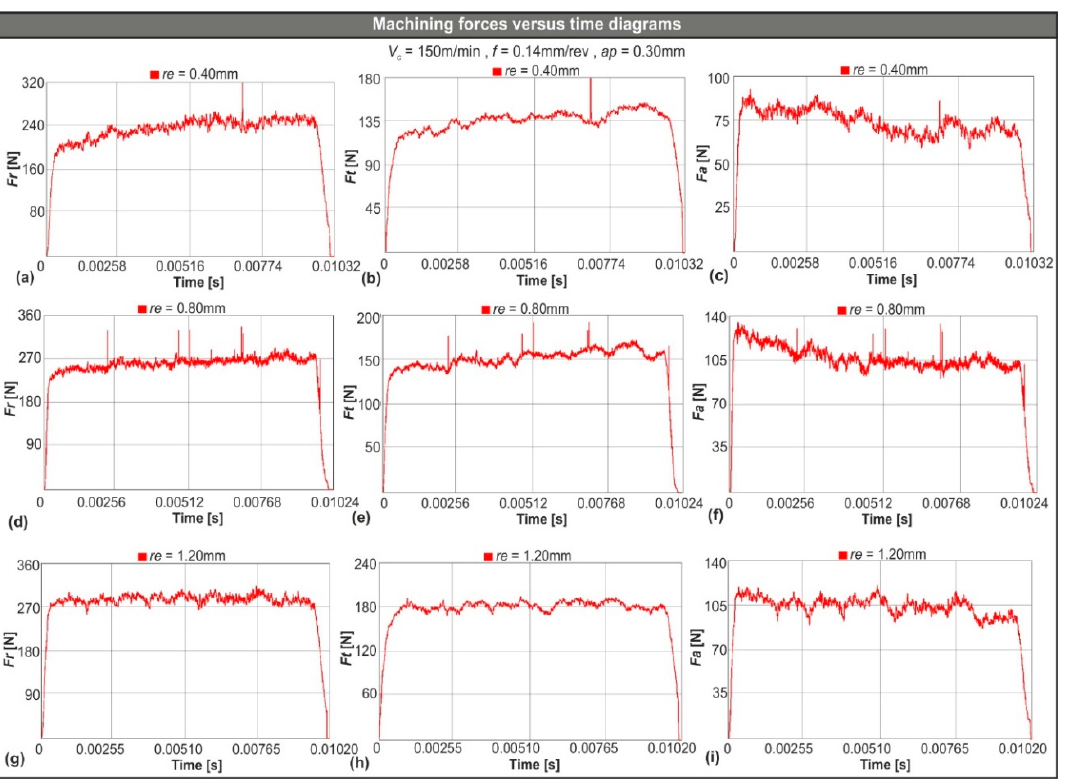
Figure 5. ( a – c ) Sample machining forces versus time diagrams for 0.40 mm nose radius, ( d – f ) 0.80 mm, and ( g – i ) 1.20 mm.